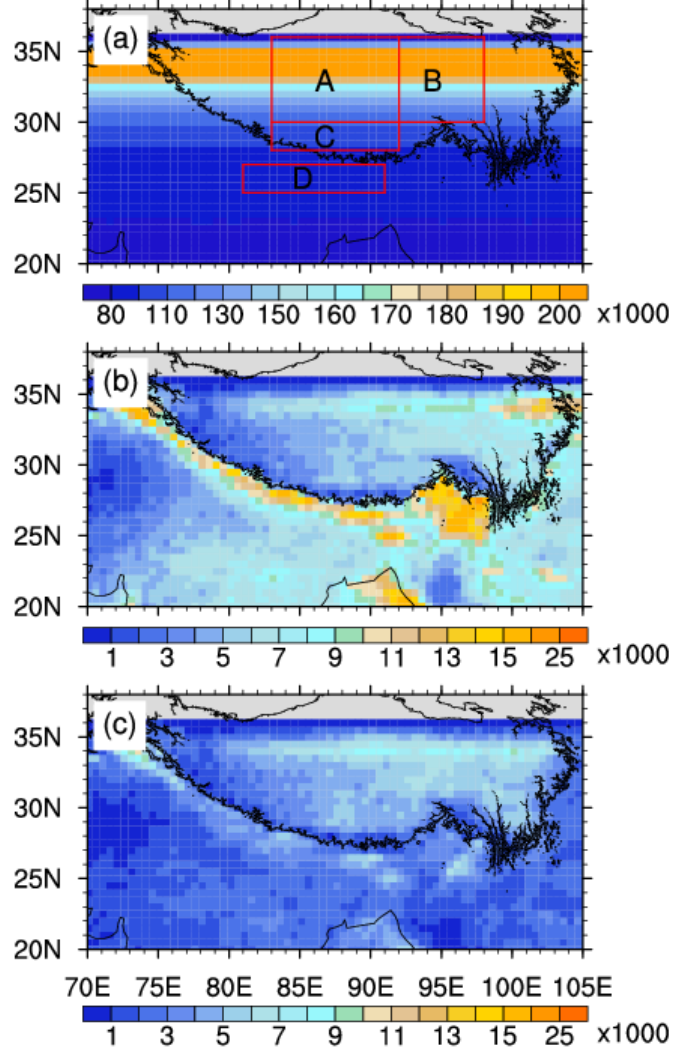
Figure 1. The distribution of ( a ) total sample, ( b ) rainy sample, and ( c ) deep convective precipitation (DCP) sample in summer over the Qinghai-Tibet Plateau (QTP) and its southern regions based on observations of TRMM PR from 1998 to 2012. These samples were statistical calculated within each 0.5° grid. The black solid line in each panel presents the altitude contour at 3000 m. Capital letters A, B, C, and D represent, respectively, the central QTP, the eastern QTP, the Yarlung Zangbo River Valley (YZRV), and the region adjacent to the southern Himalayas (RASH), where the non-plateau area is.